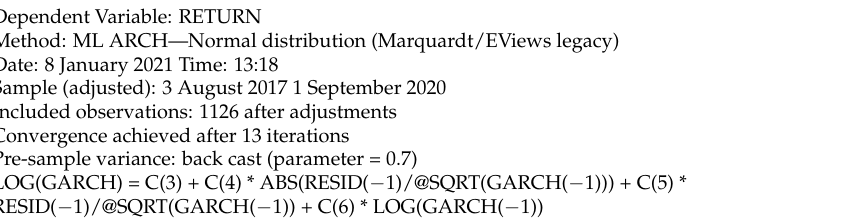
Table 8. Estimated Result of E-GARCH Model for Euro Return Index during